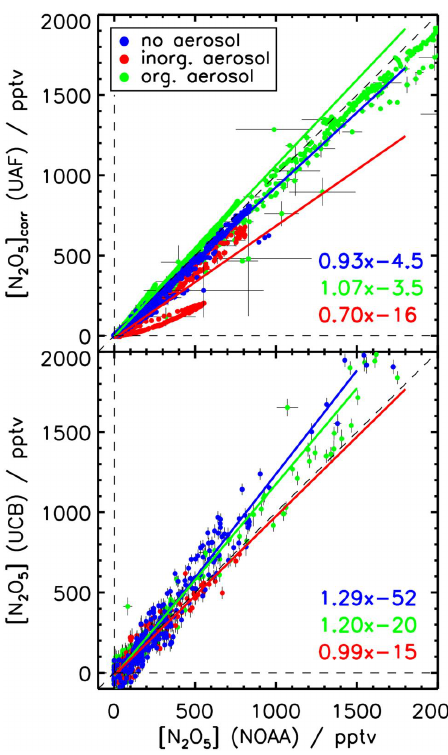
Fig. 8. Correlation between N 2 O 5 data from UAF-CRDS, UCB-LIF and NOAA-CRDS depending on the presence and type of aerosol during an experiment. TMU-LIF and MPI-LIF are not shown, be- cause instruments measured only on two days (Fig. 3). Solid lines and coloured labels give the results of the regression analysis for the different data subsets. The relationship between NOAA-CRDS and UAF-CRDS for inorganic aerosol (upper panel) falls into two parts because of the increasing deviation between measurements with in- creasing aerosol